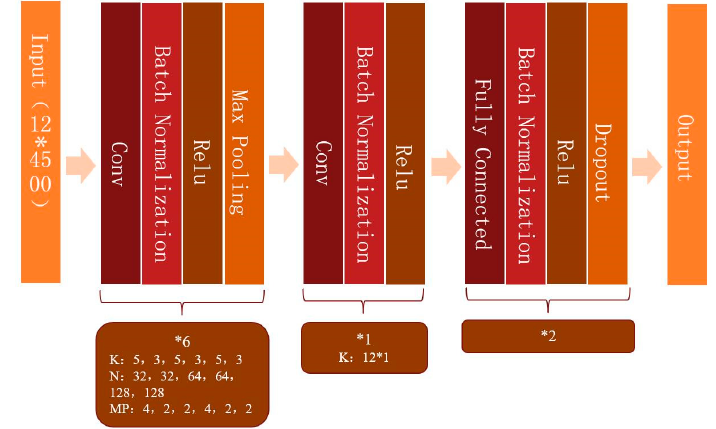
Figure 2. Model diagram.